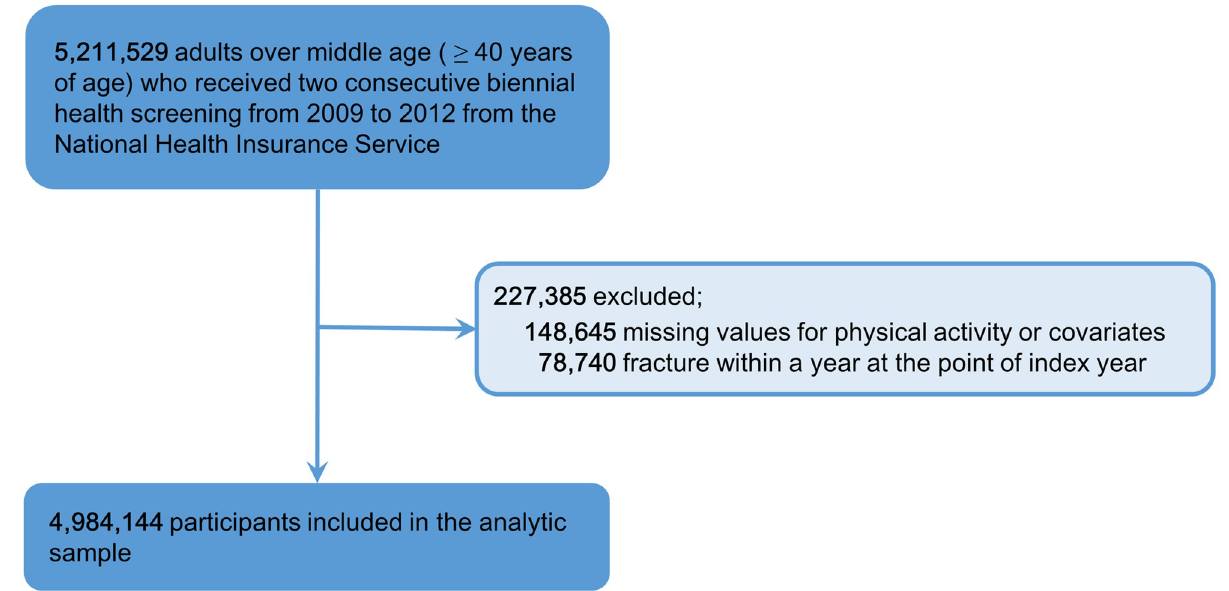
Fig 1. Flow diagram of study population